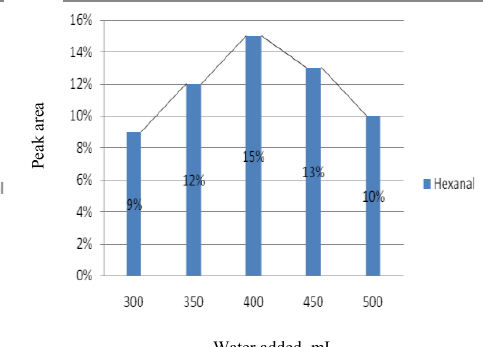
Fiber coating Water added, mL Figure 4. Comparison of the extraction Figure 5. Comparison of the extraction efficiencies of the PDMS, CAR/PDMS and efficiencies of the various additions of DVB/CAR/PDMS fibers for volatile water. compounds in the headspace of rice sample.